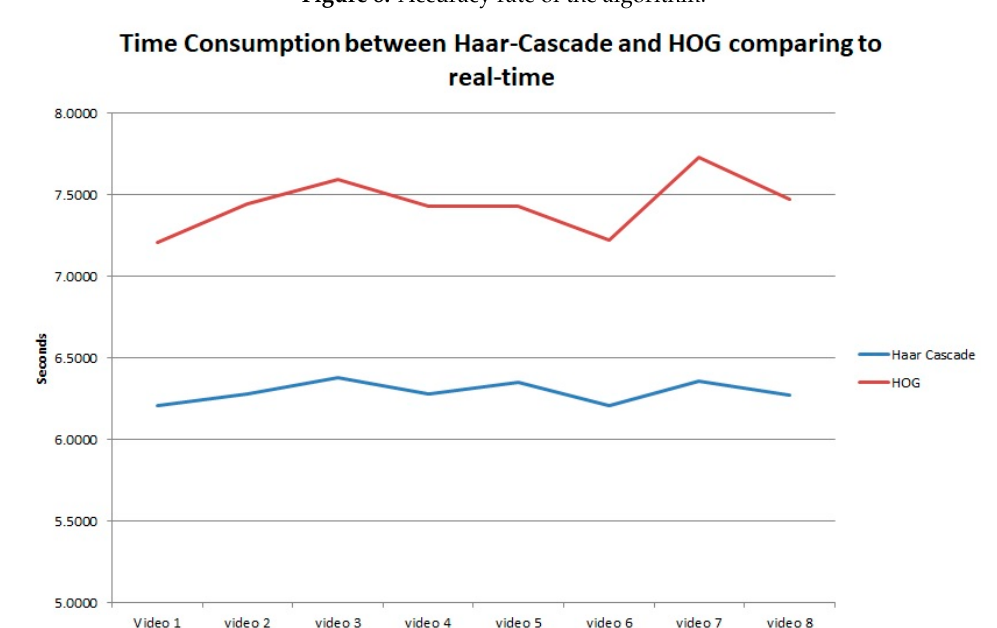
Figure 9. Time difference between the video ran with the Haar cascade and with the histogram of object gradients (HOG).